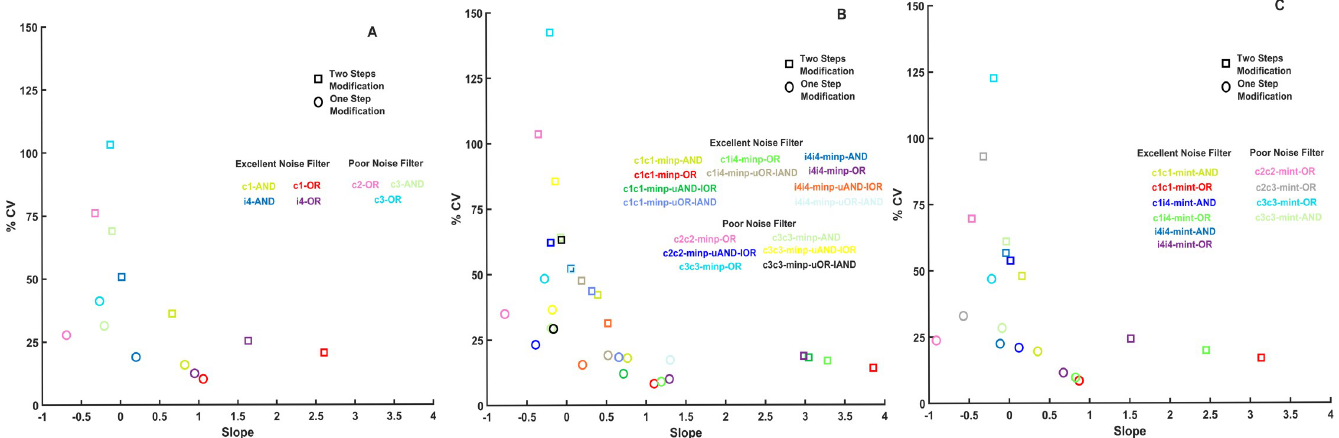
Fig 5. Comparison between FFLs containing one step and two steps modifications at each regulatory layer. Input-output relation slope and coefficient of variation in percentage (% CV) data from Figs 2D and 3 are plotted together with similar data from systems where at each layer, molecules go through 2 modification steps before getting activated. Simple FFLs (A), multi-input (B) and multi-intermediate (C) coupled FFLs all show that two step modification systems have a higher % CV. All simulations were run with the fixed parameter sets presented in the S1 Text.